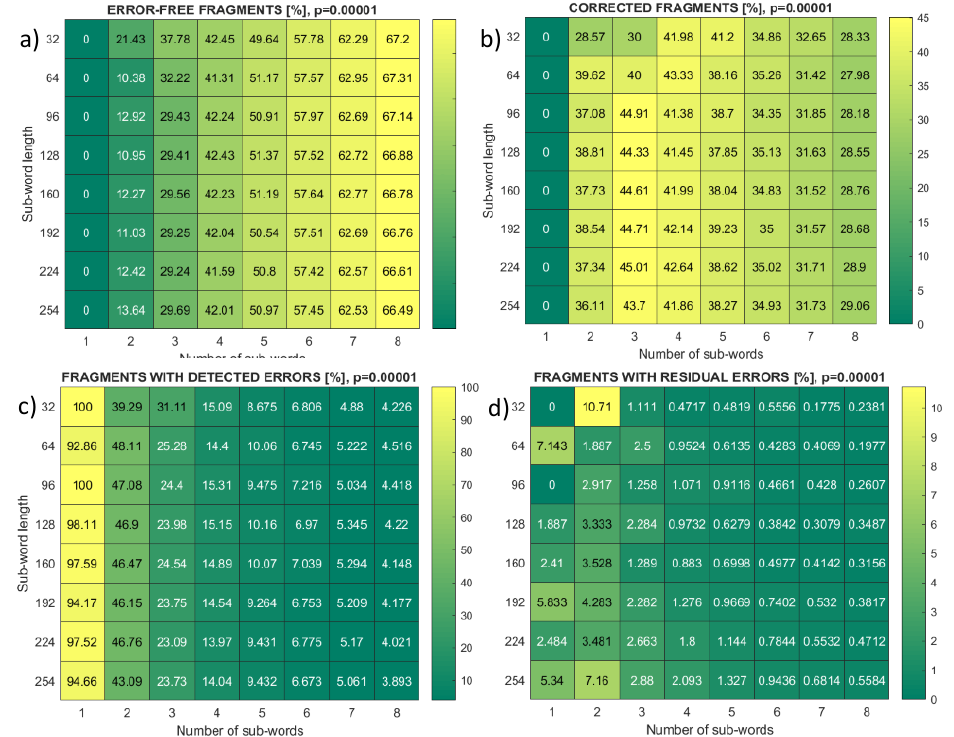
Figure 9. Heat maps of fragment error events, symbol length m = 8, bit error rate p = 10 −5 , for different fragments (sub-words) number and length within a frame. ( a ) Error-free fragments; ( b ) single error; ( c ) detected errors; ( d ) missed (residual) errors.